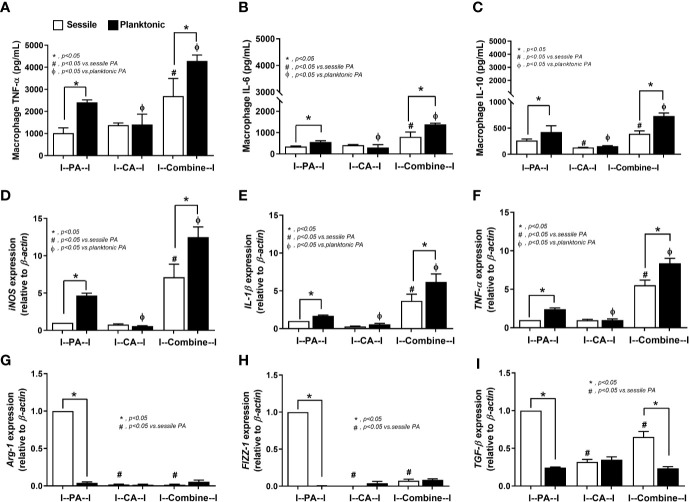
Characteristics of RAW264.7 cells (macrophages) after 6 h incubation of P. aeruginosa, C. albicans, or P. aeruginosa with C. albicans (combined) in sessile (biofilm) and planktonic form (free-living) as determined by supernatant cytokines (TNF-α, IL-6, IL-10) (A–C), gene expression of macrophage polarization of M1 (iNOS, IL-1β, TNF-α) and M2 (Arg-1, FIZZ-1, TGF-β) (D–I) are demonstrated. Mean ± SE was used for data presentation, and the differences between groups were examined by one-way ANOVA followed by Tukey’s analysis for comparisons of multiple groups or 2 groups (A–I). A p-value of < 0.05 was considered statistically significant. (Independent triplicate experiments were performed.) (*p<0.05; #
p<0.05).